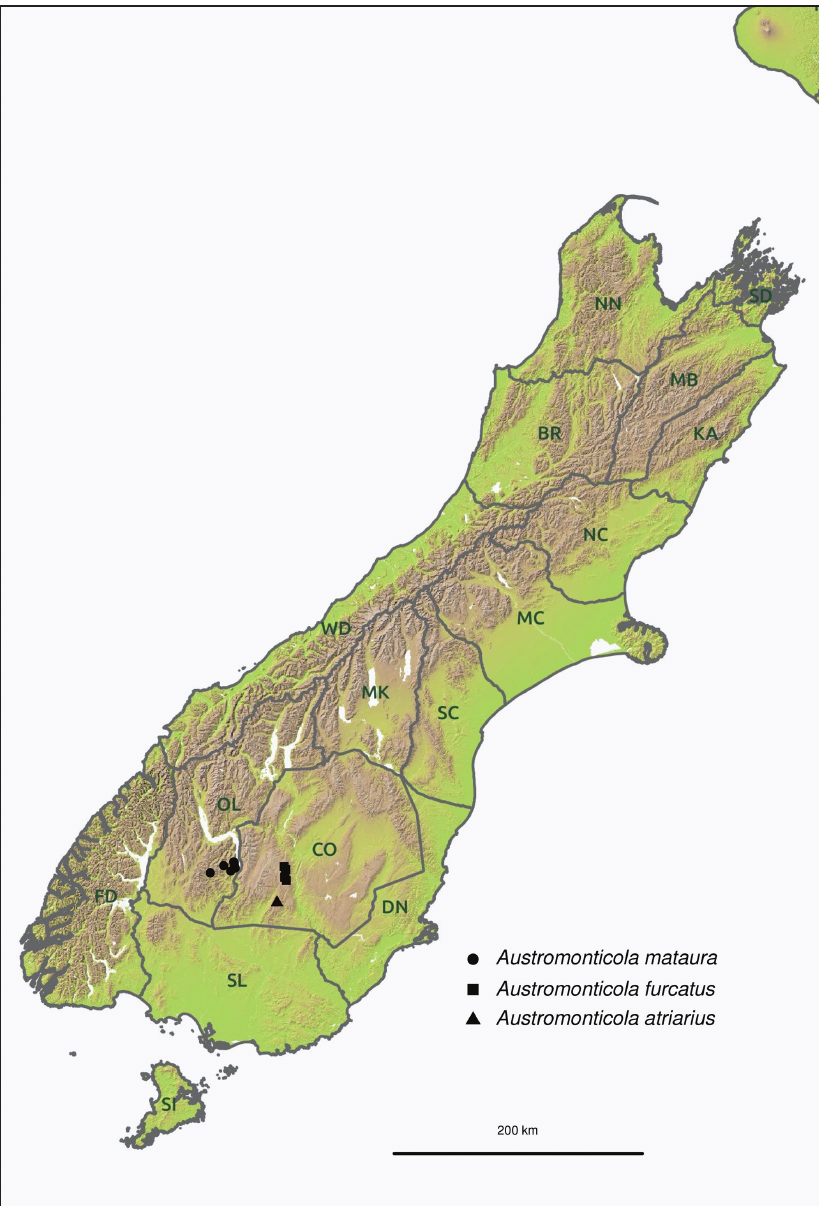
Figure 116. Distributions of Austromonticola mataura (circles), A. furcatus (squares) and A. atriarius